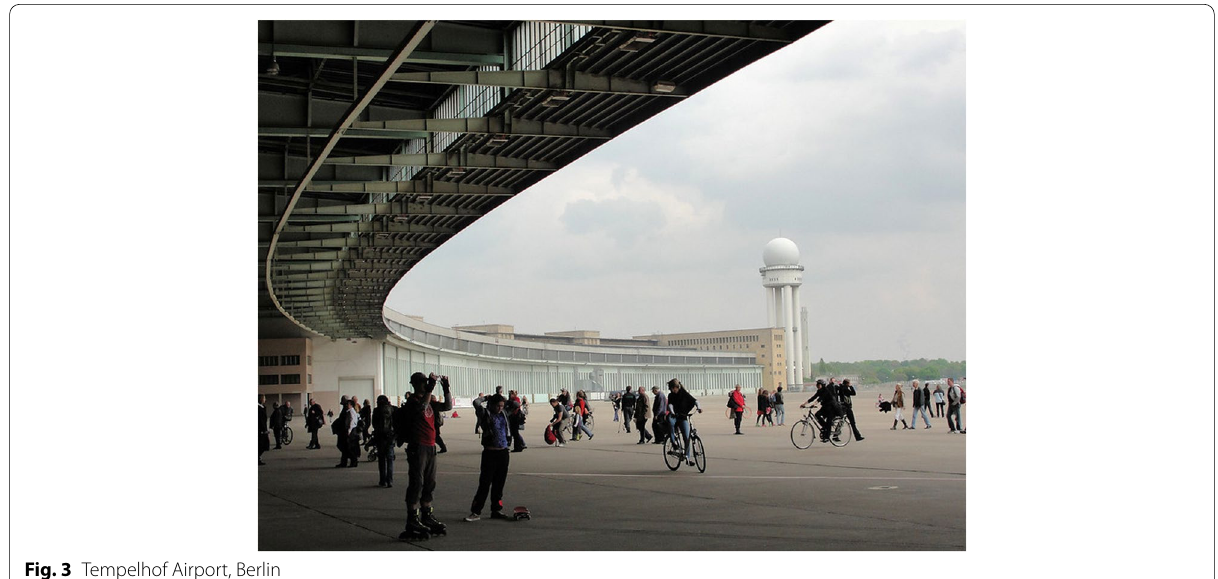
Table 4 Anticipatory analysis of the Tempelhof Airport How is it a Hybrid space ? • Highly adaptable, while grounded in history, versatile for emerging situations. • A temporal hybrid where intertwined past, present and future connota- tions are